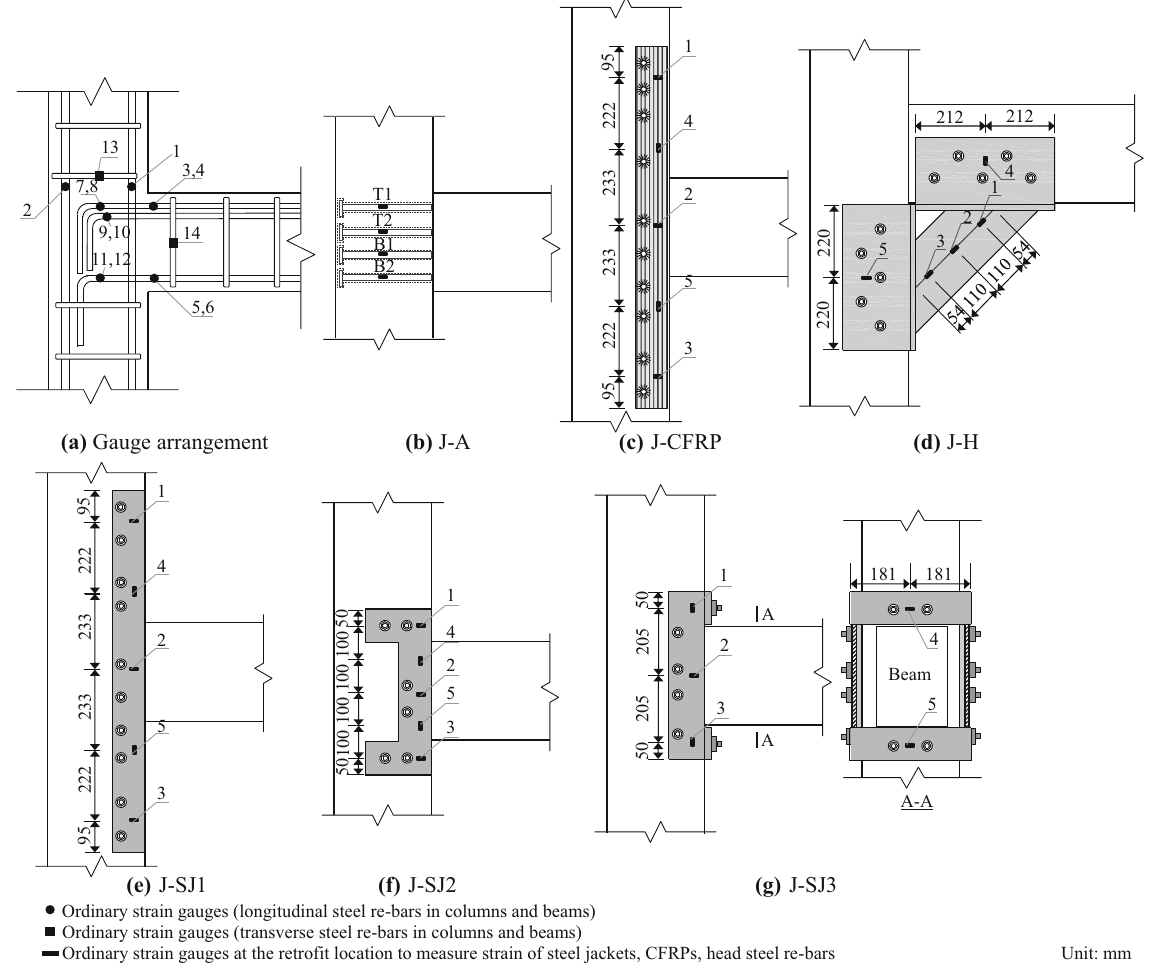
Ordinary strain gauges (longitudinal steel re-bars in columns and beams) Ordinary strain gauges (transverse steel re-bars in columns and beams) Ordinary strain gauges at the retrofit location to measure strain of steel jackets, CFRPs, head steel re-bars Unit: mm Fig. 13 Arrangement of strain gauges attached to steel re-bars and retrofit surfaces: a gauge arrangement, b J-A, c J-CFRP, d J- H, e J-SJ1, f J-SJ2, and g